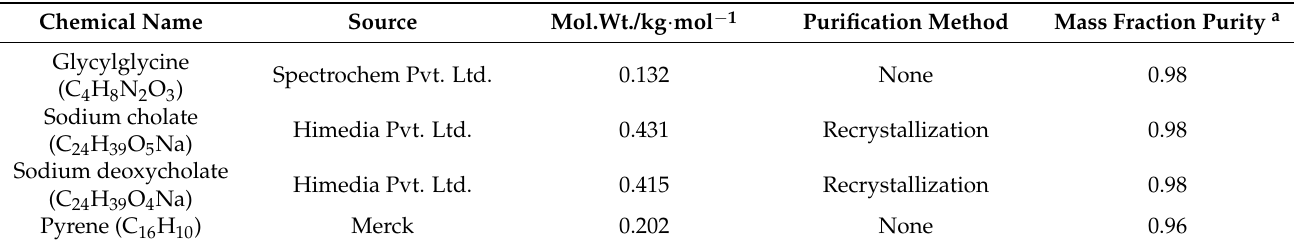
Table 1. Various specifications of chemicals taken in the present